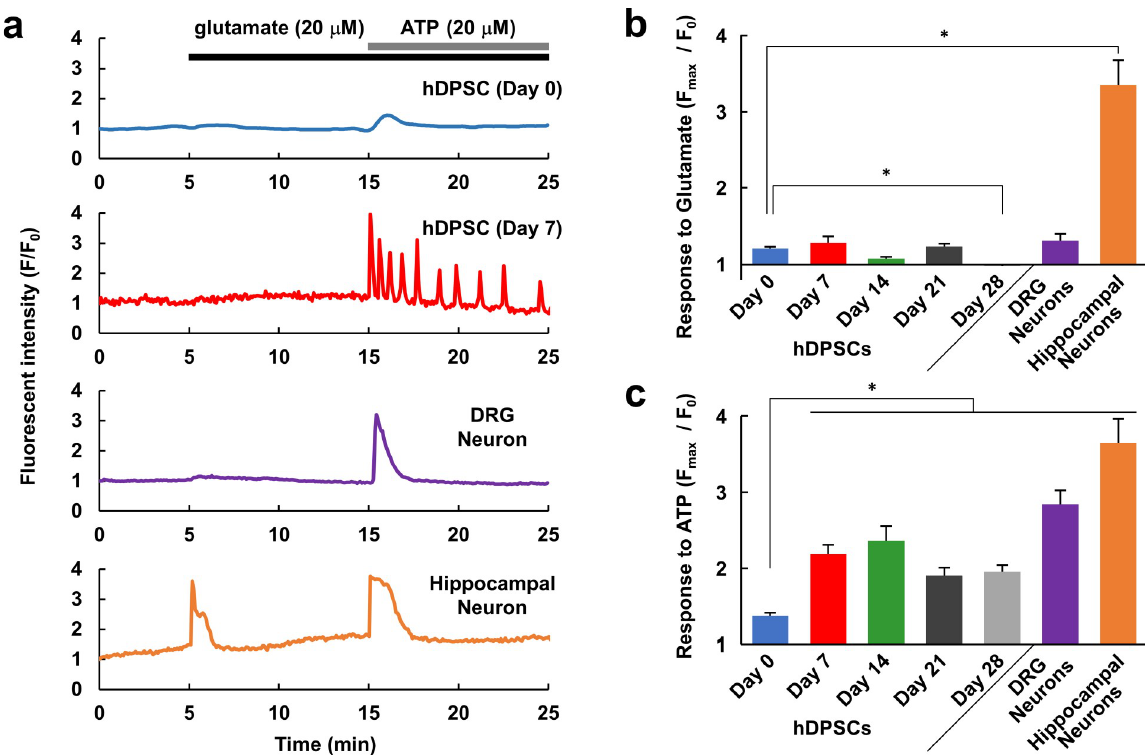
Fig 5. Ca 2+ responses of hDPSCs, DRG and hippocampal neurons. (a) Representative Ca 2+ responses to glutamate (20 μ M) and ATP (20 μ M) application in undifferentiated (Day 0) and differentiated (Day 7) hDPSCs and cultured rat DRG and hippocampal neurons. Comparison of the response amplitudes (F max /F 0 ) to glutamate (b) and ATP (c) in hDPSCs differentiated for the indicated days, DRG neurons, and hippocampal neurons (n = 210, 84, 35, 78, 94, 43, or 33 cells, respectively, from 2–5 different experiments for each condition). Error bars, standard error of the mean. � P < 0.05 compared to Day